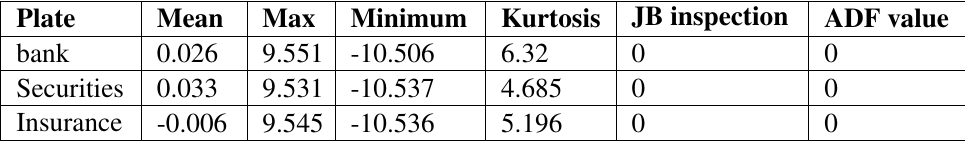
Table 1 Descriptive statistical results of the sample